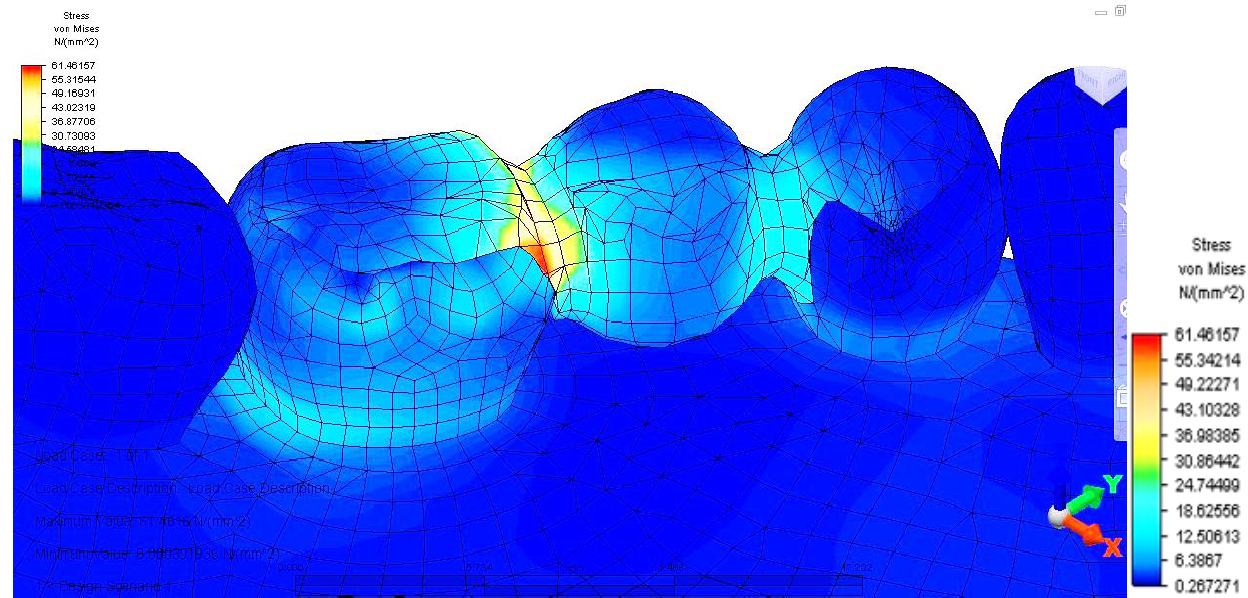
Figure 6. Tension distribution at the bridge level when the reaction force is placed in the 3.6 area.